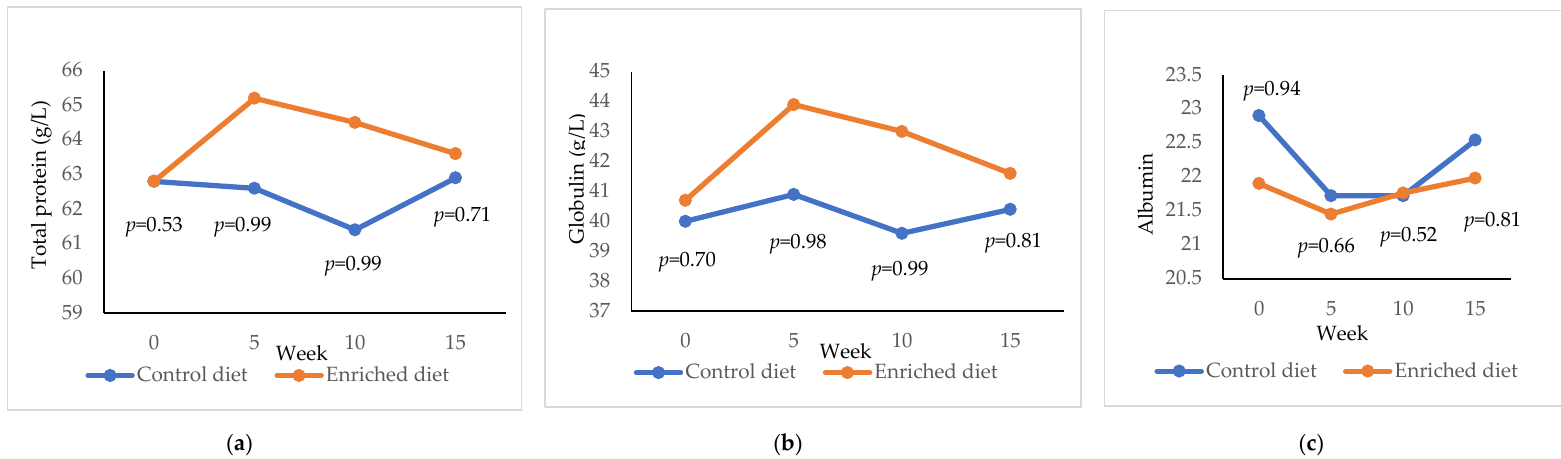
Figure 4. Evolution of ( a ) total protein; ( b ) globulin; ( c ) albumin in males fed with Control and Enriched diet. p is the probability of the difference being >0 when the difference between the diets was >0 or being <0 when this difference was <0.